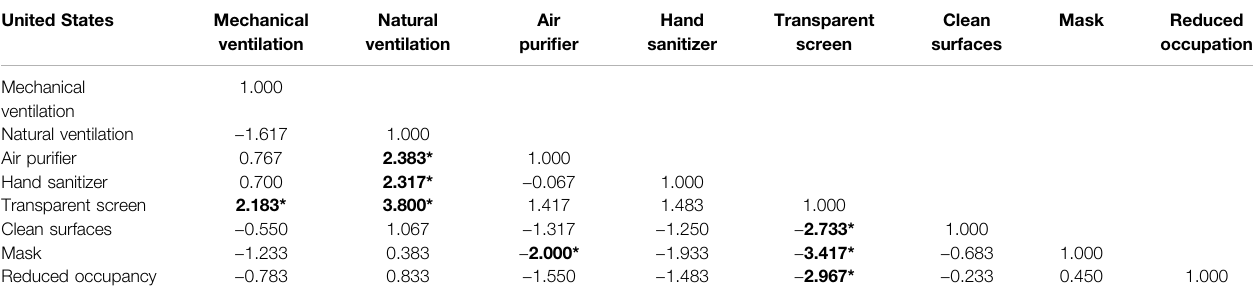
TABLE 3 | * Pairwise comparisons adjusting signi fi cance with a Bonferroni correction for eight hazard mitigation strategies at the p < 0.05 level for students in the United States. Bold values are highlighted to indicate signi fi cance. United